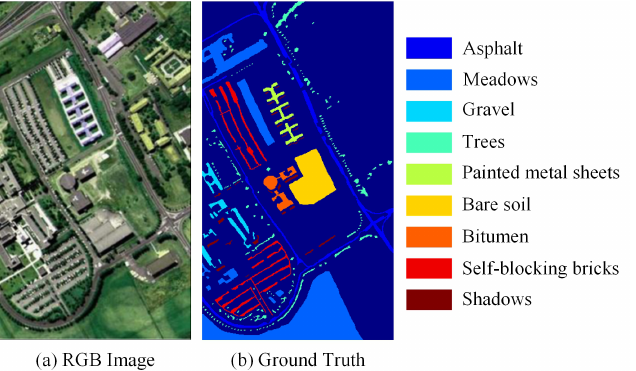
Figure 3. University of Pavia dataset. ( a ) RGB image. ( b ) Ground